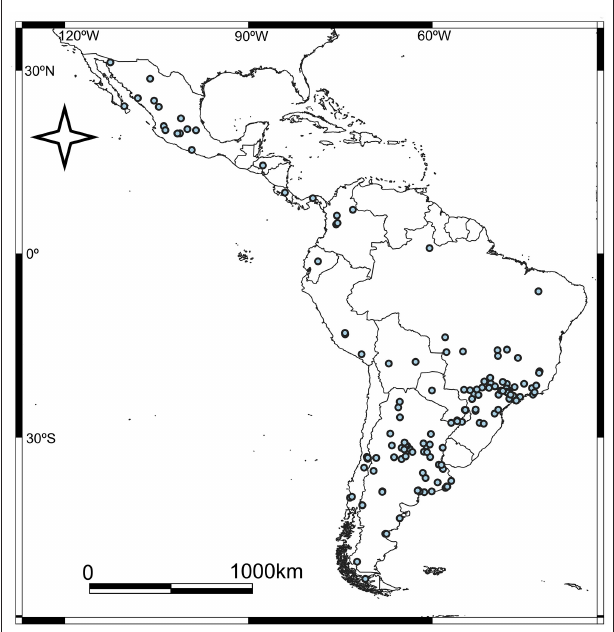
FIGURE 1 | Map of the distribution of the puma events across Latin